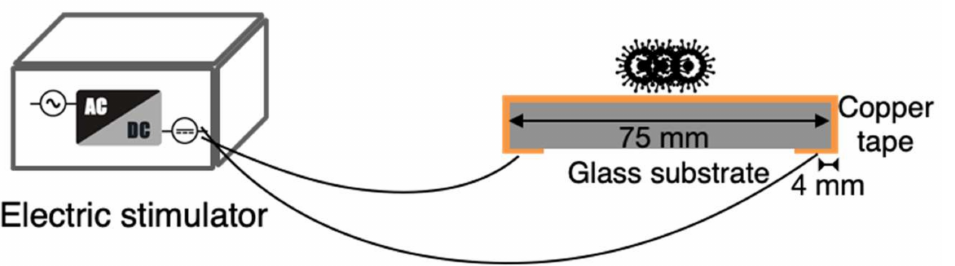
Figure 3. Schematic of the designed electrical stimulation device connected to a copper tape on a glass substrate.